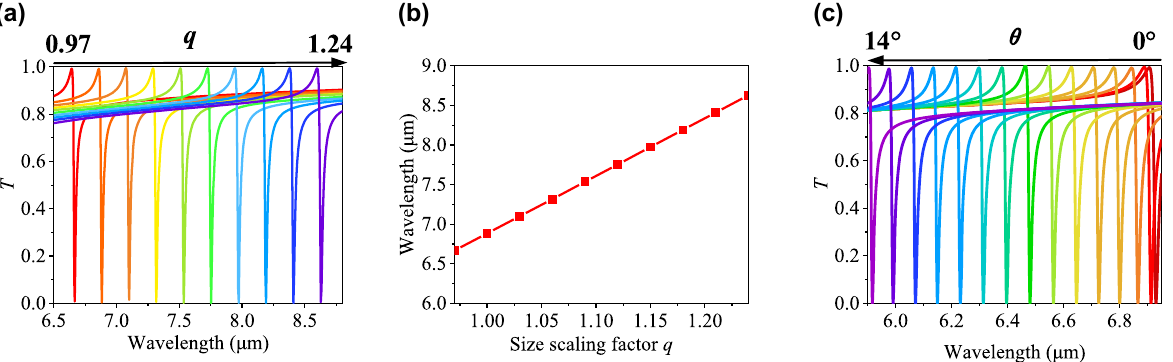
Figure 3: The dependence of the Fano resonance wavelengths on the scaling factor q and incident angle 𝜃 . (a) Transmission spectra of the metasurface with different square disk size scaling factor q , where other parameters remain as the original settings. (b) The linear relation between resonant wavelength and q . (c) Transmission spectra with different incident